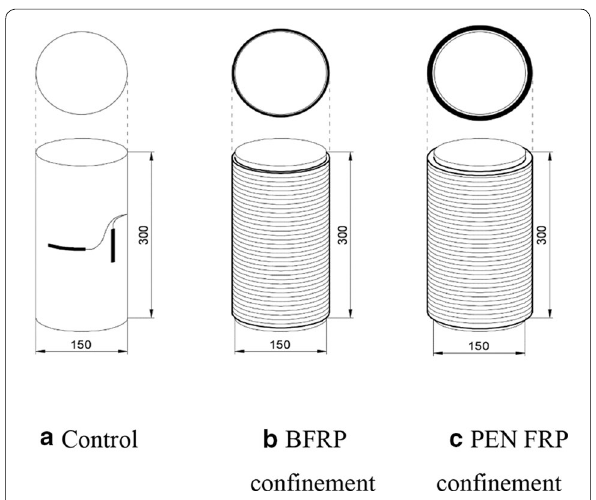
Fig. 4 Concrete cylinder